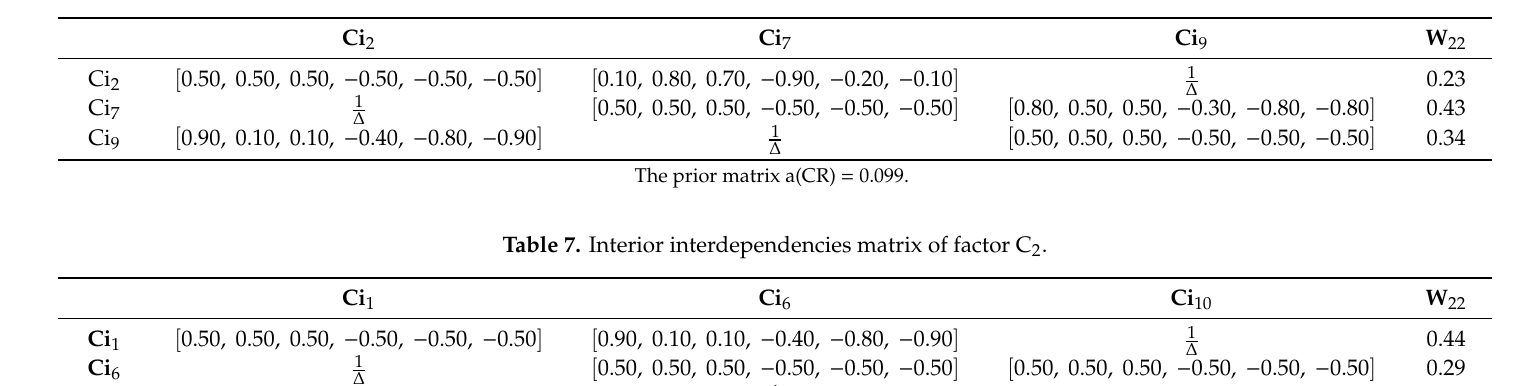
Table 6. Interior interdependencies matrix of factor C 1 .